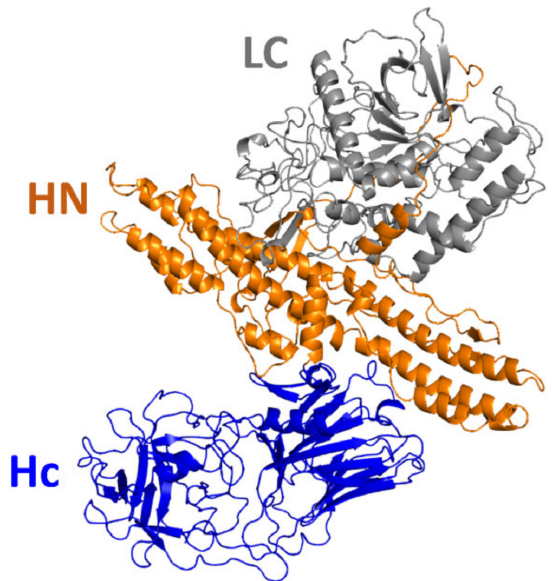
Figure 1. Molecular structure of the full length of BoNT/A1, experimentally resolved with X-ray diffraction. Botulinum neurotoxins are each composed of an LC domain, an HN sub-domain and an Hc sub-domain. The Hc sub-domain is responsible for binding of neurotoxin to neuronal membranes. Once attached, toxin is endocytosed by the cell. Then, upon acidification of the inside of the vesicle, the HN sub-domain is responsible for translocation of the LC domain from the vesicle to the cytoplasm. Finally, the LC chain of neurotoxin cleaves the SNARE proteins, which prevents fusion of the neurotransmitter vesicles with the plasma membrane, resulting in inhibition of neurotransmission. Hc is depicted in blue, HN is depicted in orange and LC is depicted in